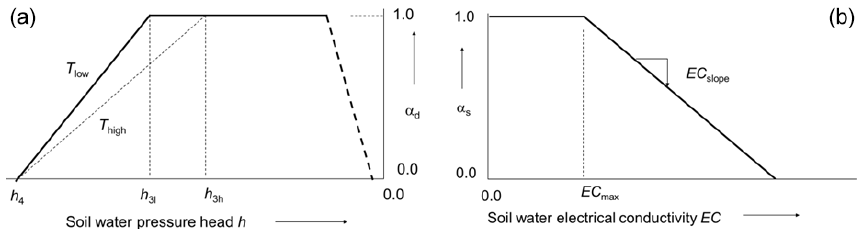
Figure 2. (a) Transpiration reduction factor α s as function of soil water pressure head and (b) transpiration reduction factor α s as function of soil water electrical conductivity.